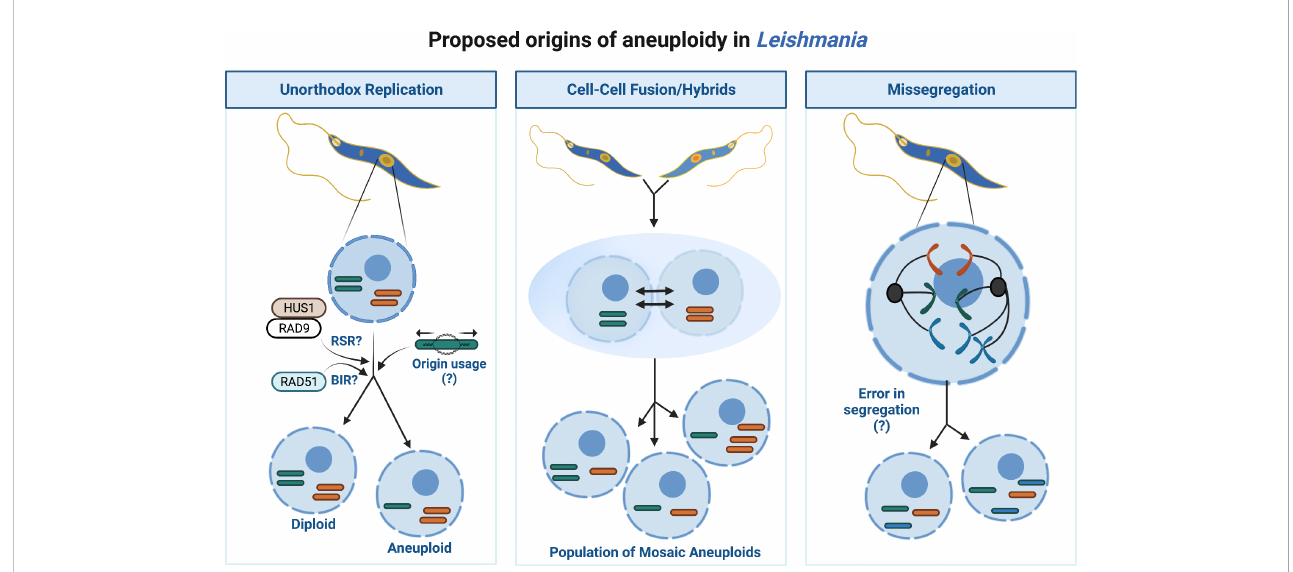
FIGURE 2 Proposed origins of aneuploidy in Leishmania. Aneuploidy in Leishmania may arise through several different processes or from a combination of events as illustrated. Unorthodox DNA replication may enhance opportunities for replication associated stress, for instance the potential usage of replication stress response (RSR) machinery for subtelomeric duplication and/or BIR to duplicate the chromosome cores may lead to under- or -over replication of chromosomes and thus aneuploid daughters. Cell-Cell fusions/hybrids may arise within the population leading to a fusion of cells each containing different chromosome numbers or putative hybrid events between different Leishmania species. Missegregation of chromosomes from mother cell to daughters may perpetuate aneuploidy, though the underlying biological processes permitting abnormal segregation are